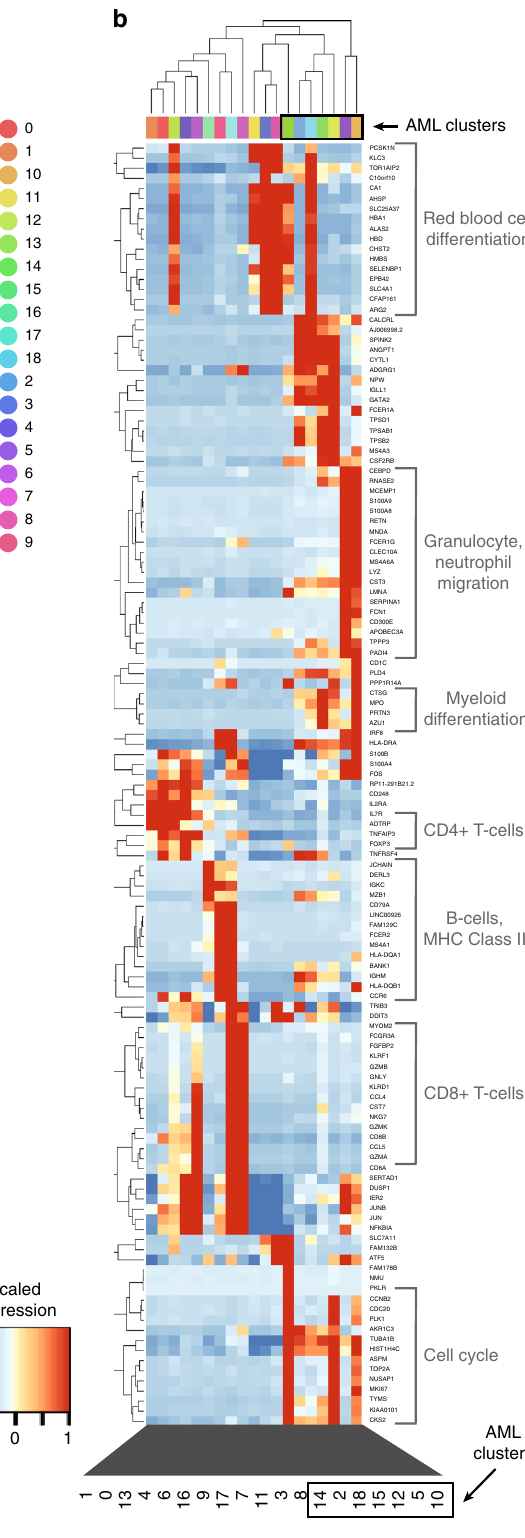
Fig. 2 Clustering, overview of expression heterogeneity, and copy number analysis in 809653. a t-SNE projection of scRNA-seq data, with cells colored according to graph-based cluster assignment; putative AML clusters (based on later analyses) circled. b Hierarchical clustering of the most heavily weighted genes in each principal component, averaged within graph-based clusters. Each column represents a cluster from panel a . c CNV analysis: blue, cells with detected CNVs; gray, no detected